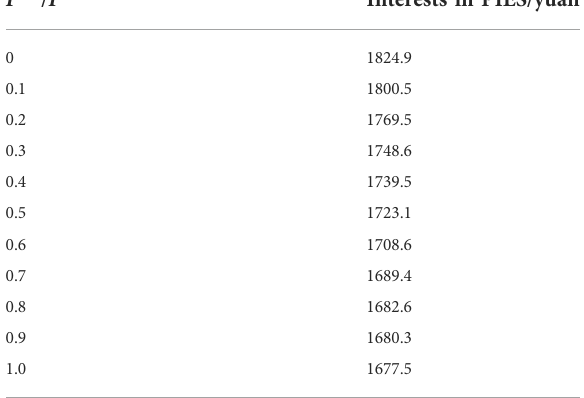
TABLE 4 Bene fi ts of the PIES under different adjustable uncertainty levels. Γ PV / Γ WT